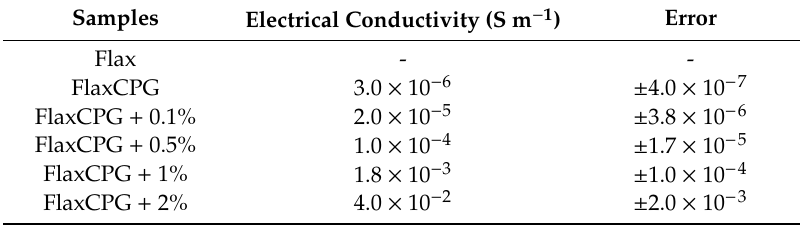
Table 2. Electrical conductivity values of the developed fibrous systems and corresponding